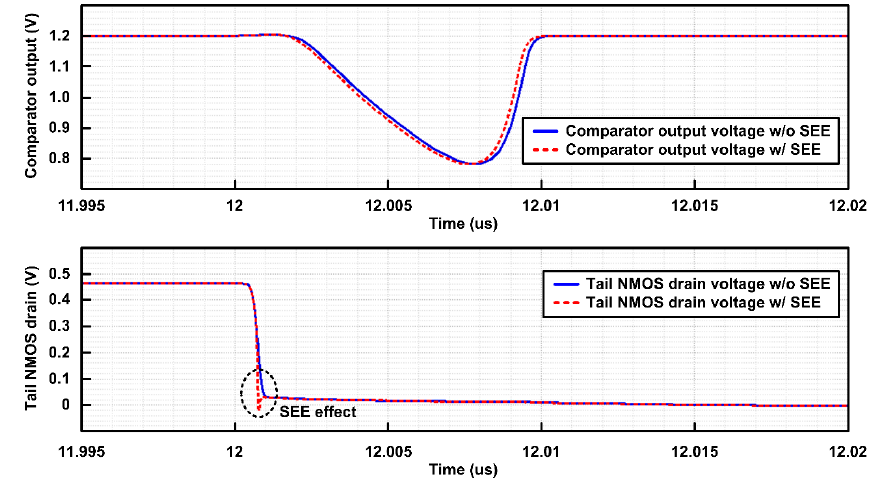
Figure 17. SEE simulation results of the digital comparator.